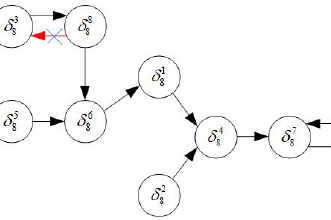
Figure 3. The state transfer graph of system (20) under P and the control (24) with s = 8, k ∗ = 2 and α (cid:48) ( 2,8 ) =